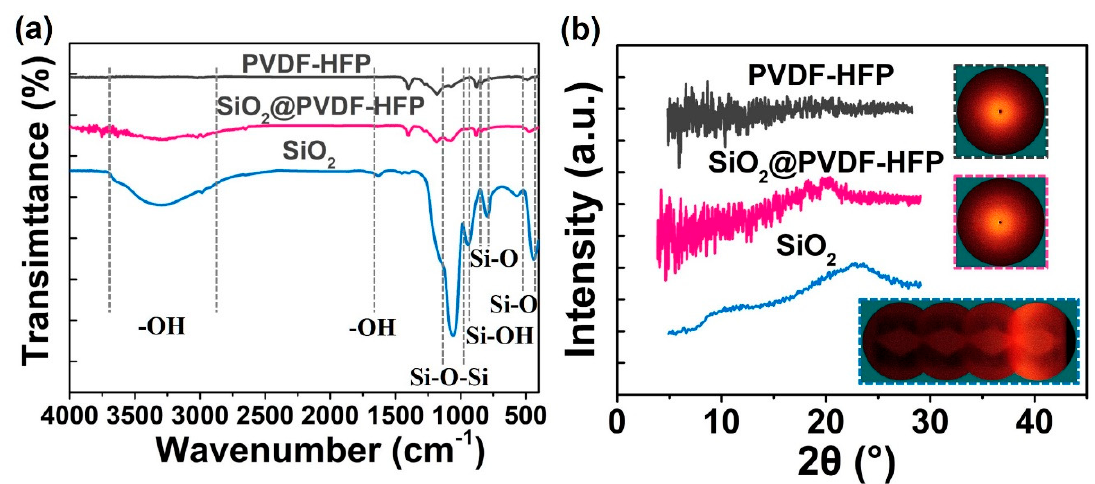
Figure 4. ( a ) FTIR spectrum and ( b ) XRD curves of PVDF-HFP, SiO 2 nanoparticles, and multi-structured SiO 2 @PVDF-HFP nanofibrous membrane.